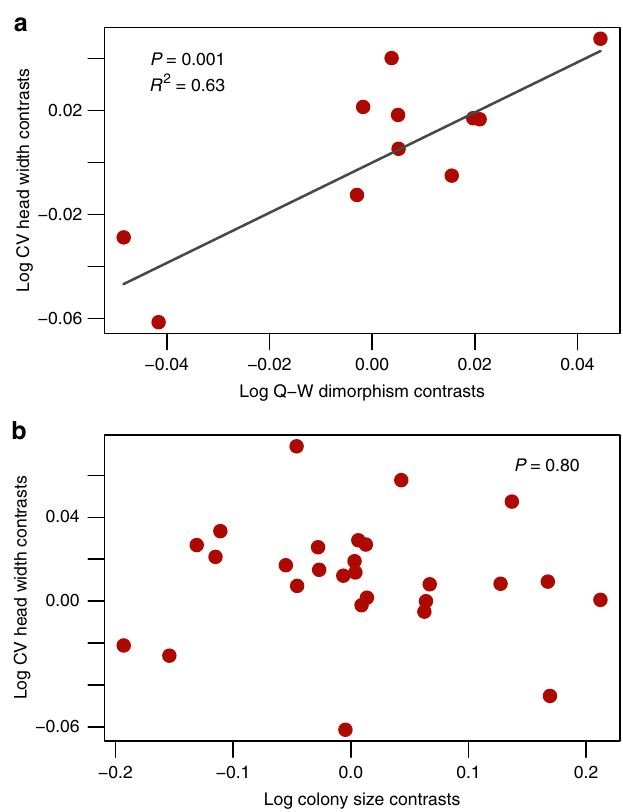
Fig. 2 Factors explaining differences between species in worker diversity. a Relationship between queen-worker dimorphism (log-transformed) and worker diversity (log-transformed standard deviation of head width) ( N = 12 species). The phylogeny is based on ref. 18 and a generalized least squares model (GLS) assuming Brownian motion was applied. The best fi t line is based on a linear regression through the origin based on phylogenetically independent contrasts (PICs). Queen-worker dimorphism explained 63% of the variation in worker size variation between species. b Relationship between colony size (log-transformed) and worker diversity (log-transformed standard deviation of head width) ( N = 27 species). A GLS model revealed no relationship between colony size and